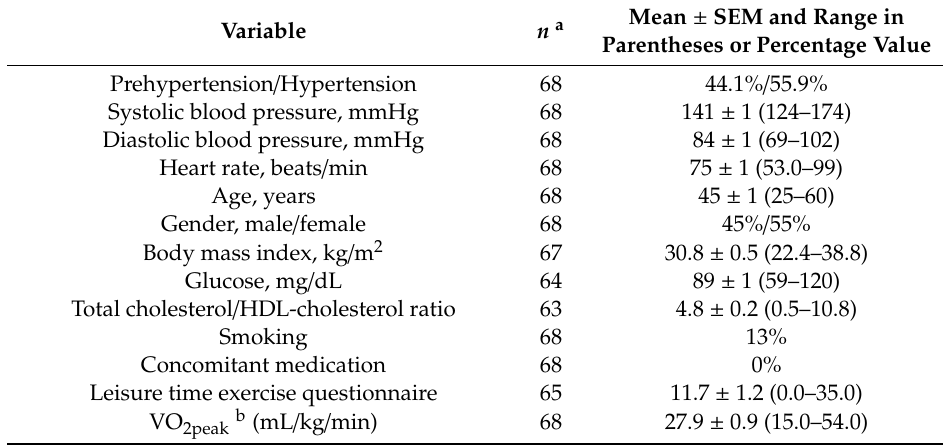
Table 2. Demographic, metabolic and health behavior characteristics of the study participants before the